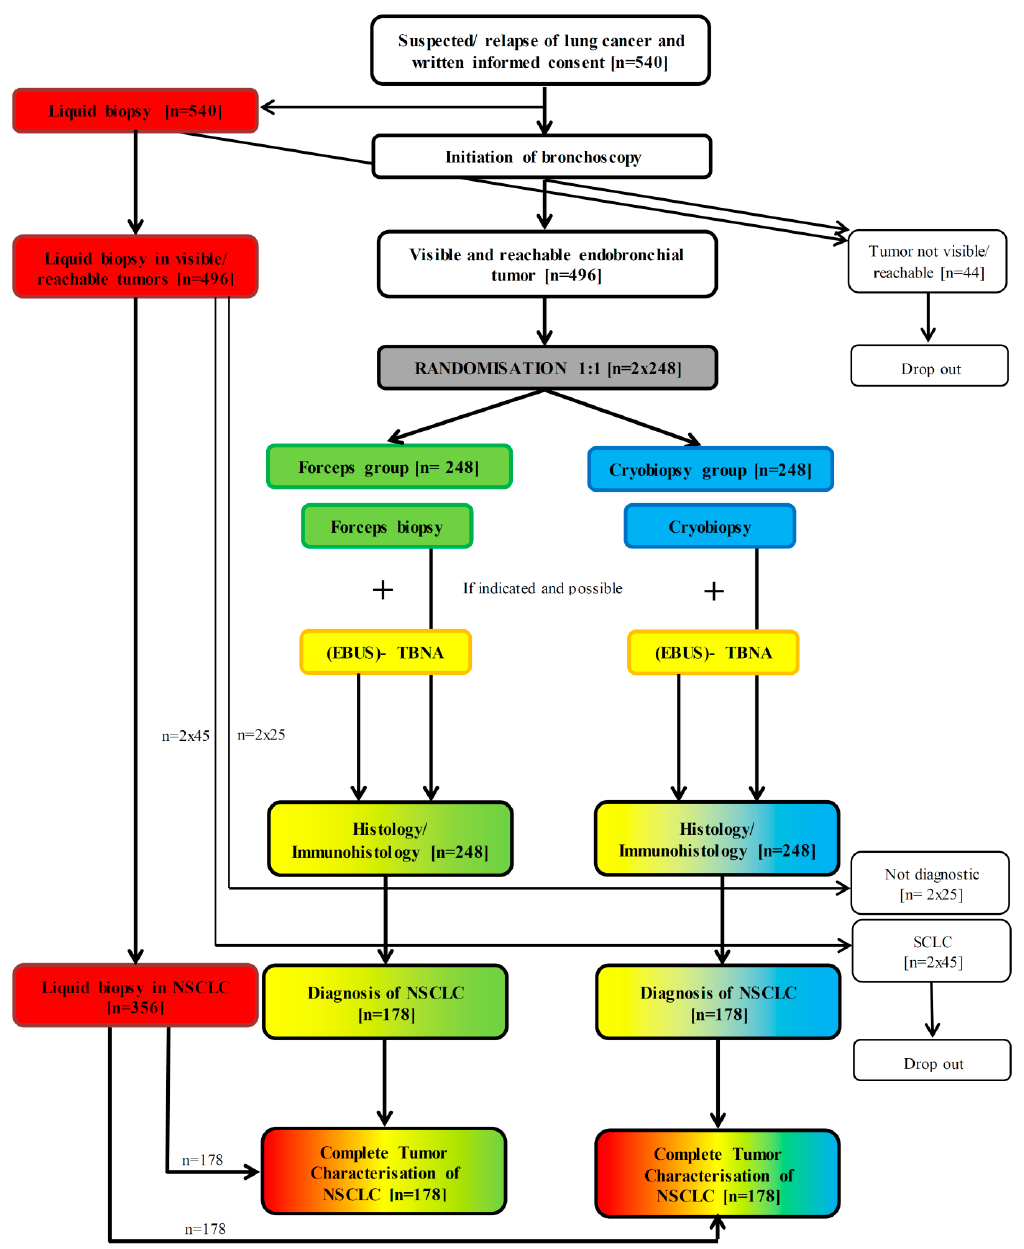
Figure 1. Flow chart of applied techniques and procedures. Assignment of colors: forceps biopsy—green; cryobiopsy—blue; (EBUS-) TBNA—yellow; liquid biopsy—red; (EBUS-) TBNA—endobronchial ultrasound guided transbronchial needle aspiration; NSCLC—non-small cell lung cancer; SCLC—small cell lung cancer.